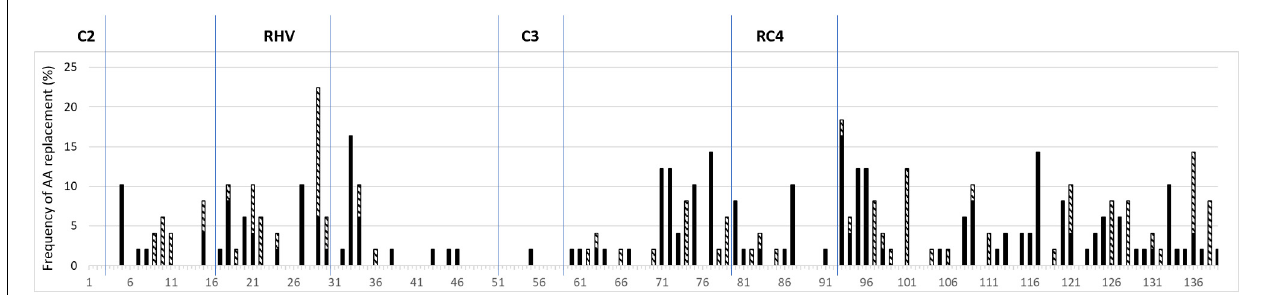
FIGURE 5 | Frequency of mutations resulting in conservative (black columns) and non-conservative (hatched columns) amino acid replacements in different regions of the Prunus S -ribonuclease gene. The numbers in axis x refer to the amino acid positions in the alignment, and conserved and RHV regions of the protein are labeled according to Ushijima et al.